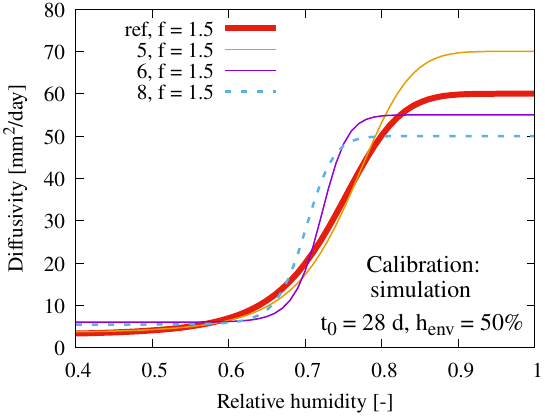
Figure 10. Di ff usivity functions giving the best agreement with the reference simulations of axial shrinkage of symmetrically drying slabs with various thicknesses ( h env = 50%, t 0 = 28 days, Fig. 9).